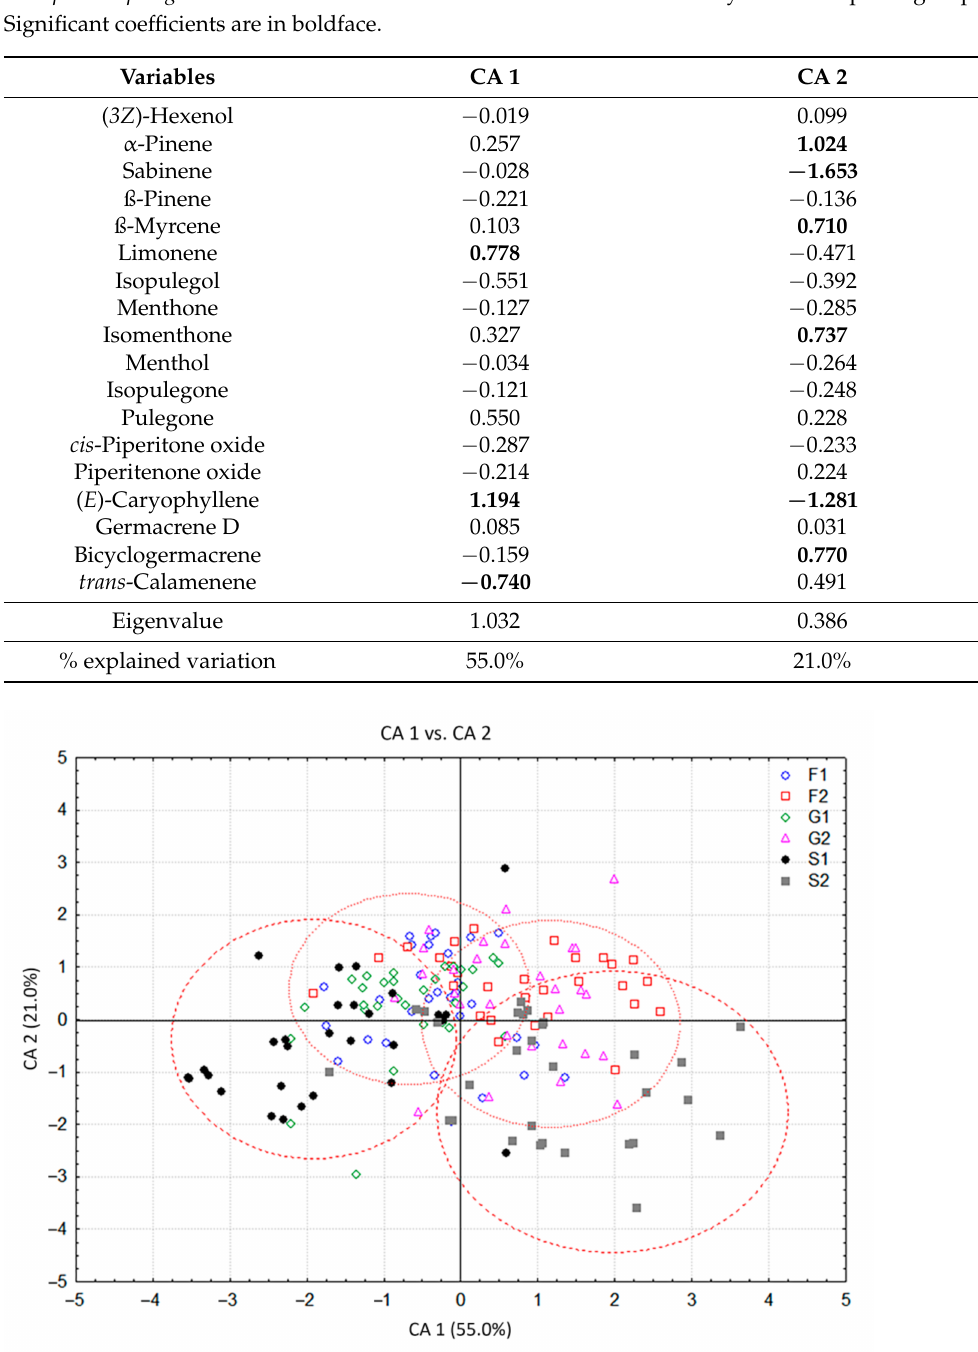
Figure 5. Canonical discriminant analysis (CDA) based on contents of 18 Clinopodium pulegium HS volatiles isolated from 180 plants of six a priori